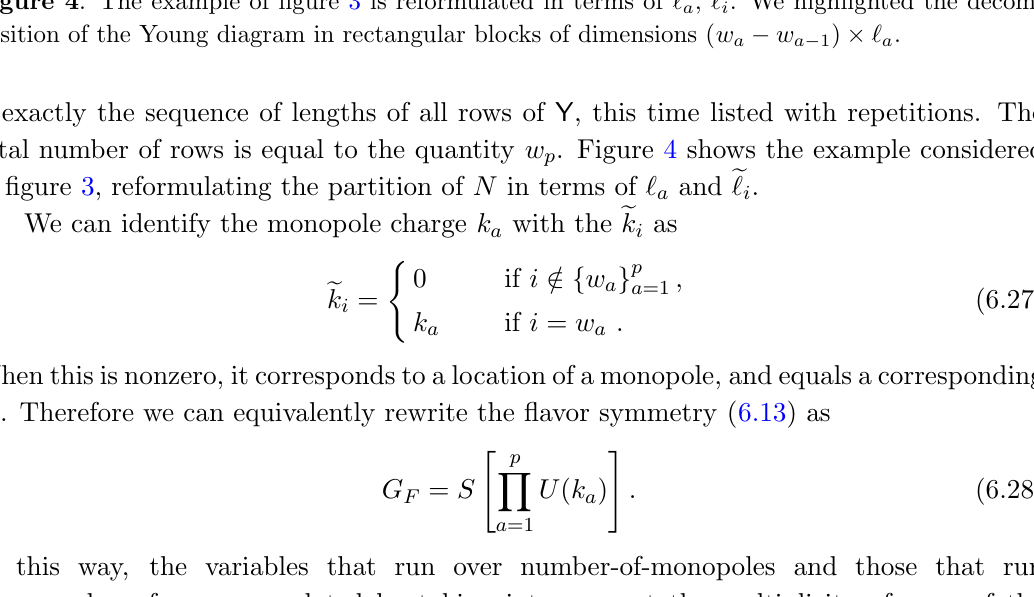
Figure 4 . The example of (cid:12)gure 3 is reformulated in terms of ‘ position of the Young diagram in rectangular blocks of dimensions ( w a